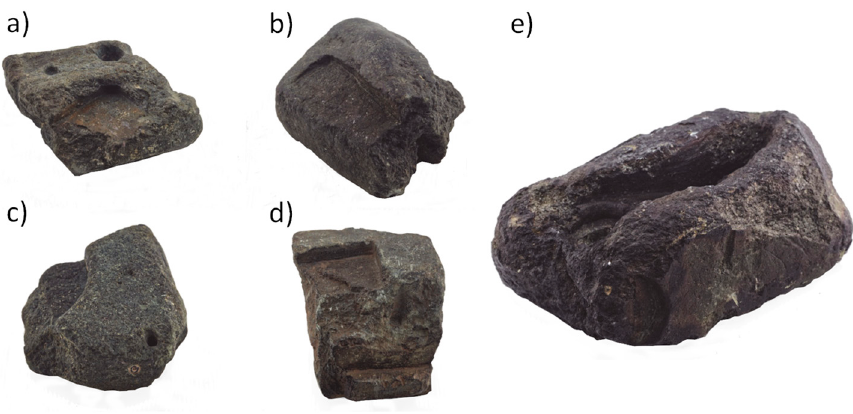
Figure 2. Views of the five stone moulds studied: ( a ) B1; ( b ) B2; ( c ) B3; ( d ) N1; ( e ) S1.